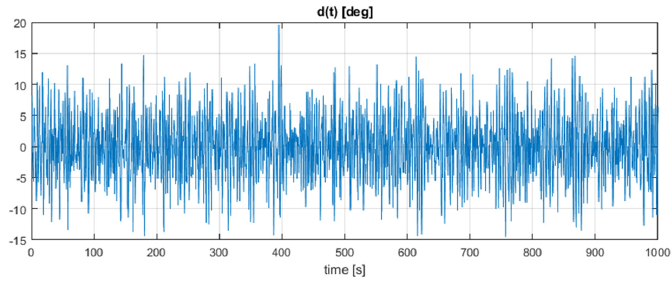
Figure 4. Coloured-noise disturbance used in simulation.